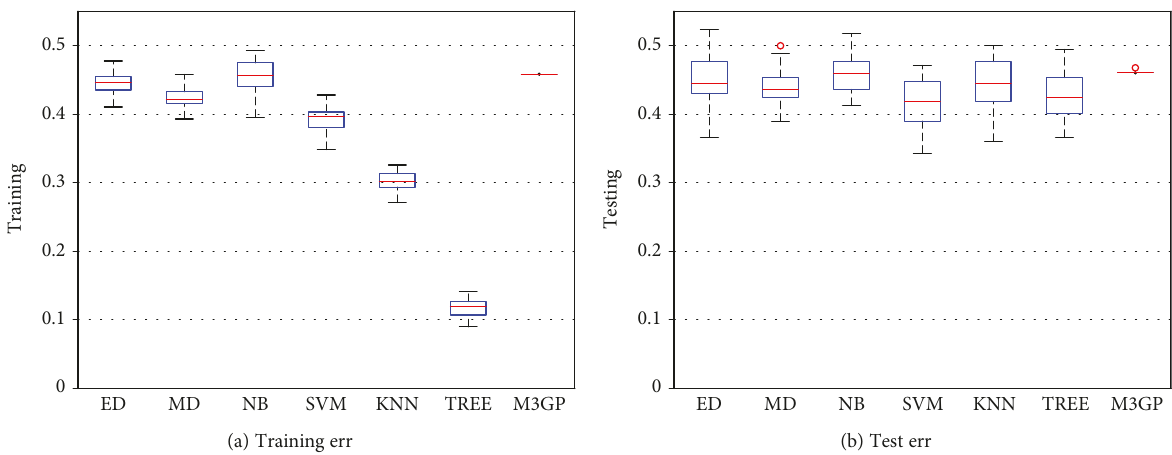
Figure 2: Boxplot reporting the errors of the tested classi fi ers in the both training (a) and test (b)